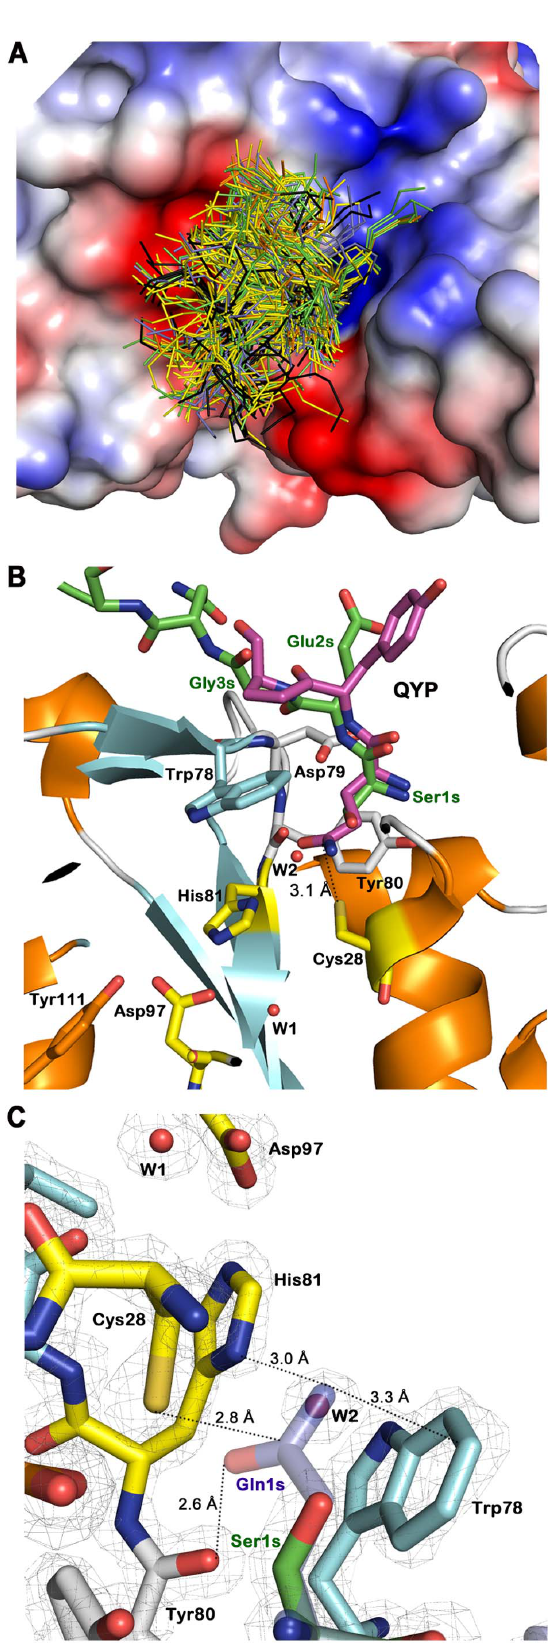
Figure 3. Docking study and suggested binding pose of N- terminal glutamine peptide in hNtaq1. (A) Tripeptides docking study of hNtaq1. Categorized by features of its second residue,